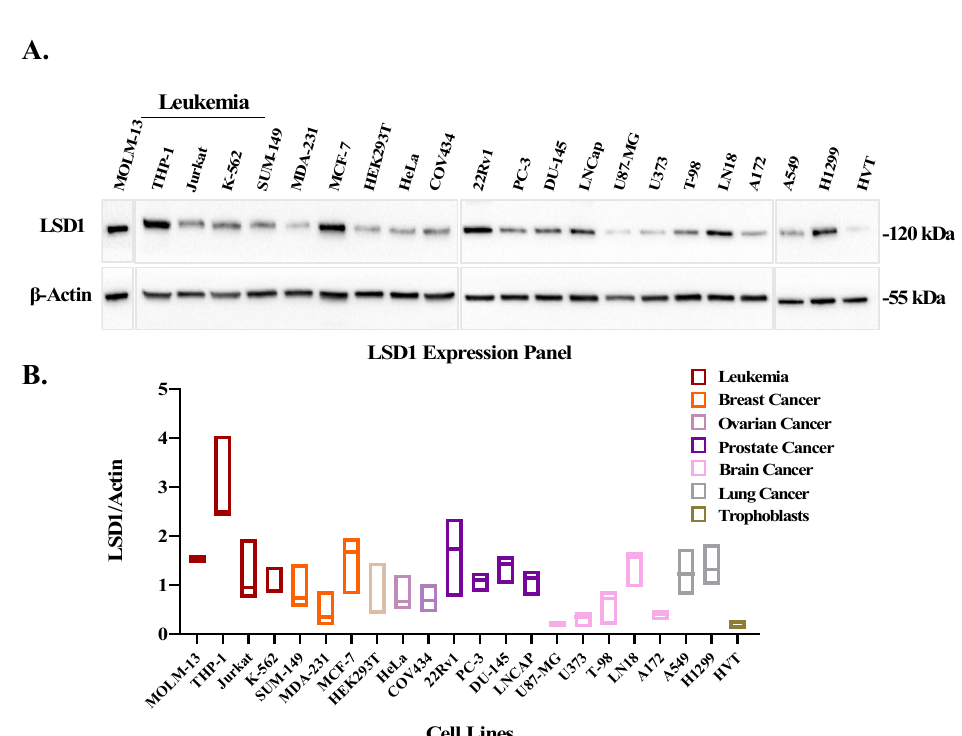
Figure 3. LSD1 expression profile of different cancer cell lines and non-cancerous HVT cells. ( A ) Western blot analysis of the LSD1 expression in different cancer types. Full Western blot images can be found in Figure S29. ( B ) quantification of LSD1 levels normalized to actin using Image J software.